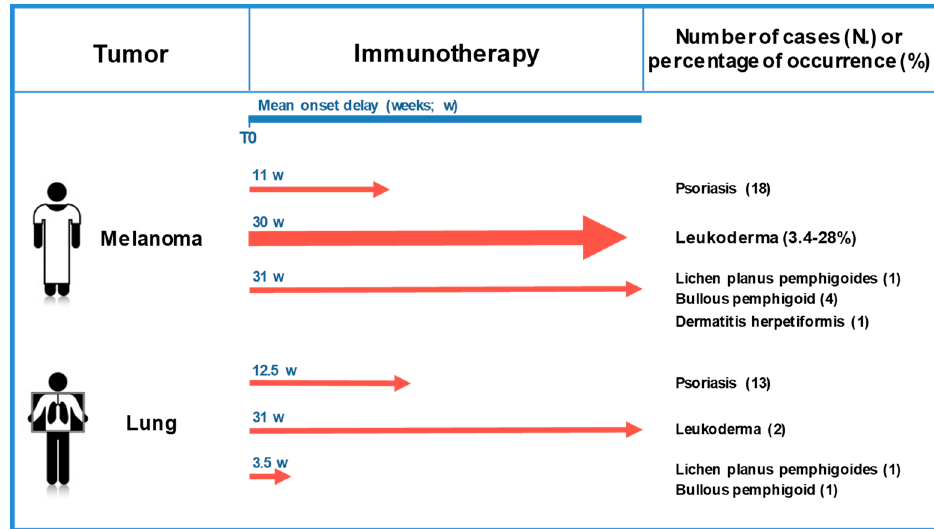
Figure 3. Skin irAEs in patients diagnosed with cutaneous melanoma or lung cancer undergoing immunotherapy with check-point inhibitors. The mean onset delay from therapy initiation (T0) is reported. Leukoderma cases are significantly higher in patients treated with check-point inhibitors for melanoma than for those with lung cancer (thicker arrow). Instead, other autoimmune cutaneous irAEs are similarly